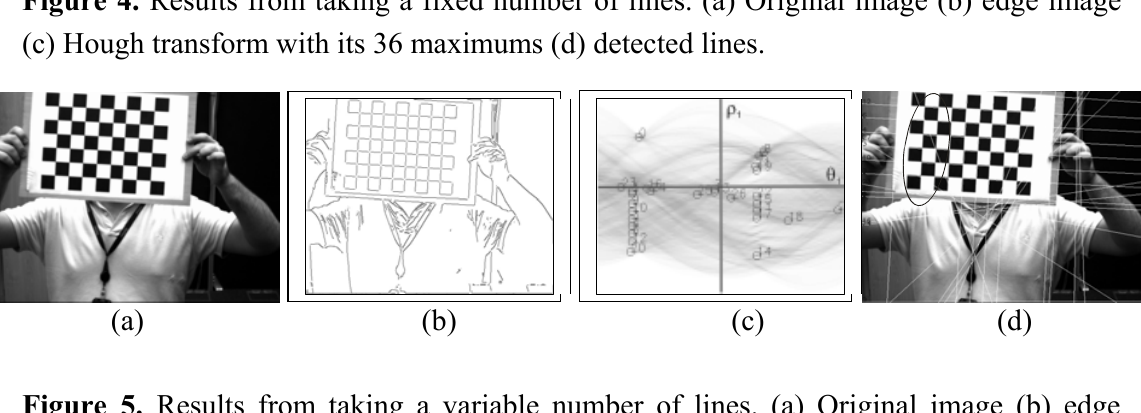
Figure 5. Results from taking a variable number of lines. (a) Original image (b) edge image (c) Hough transform with the maximums (d) detected lines